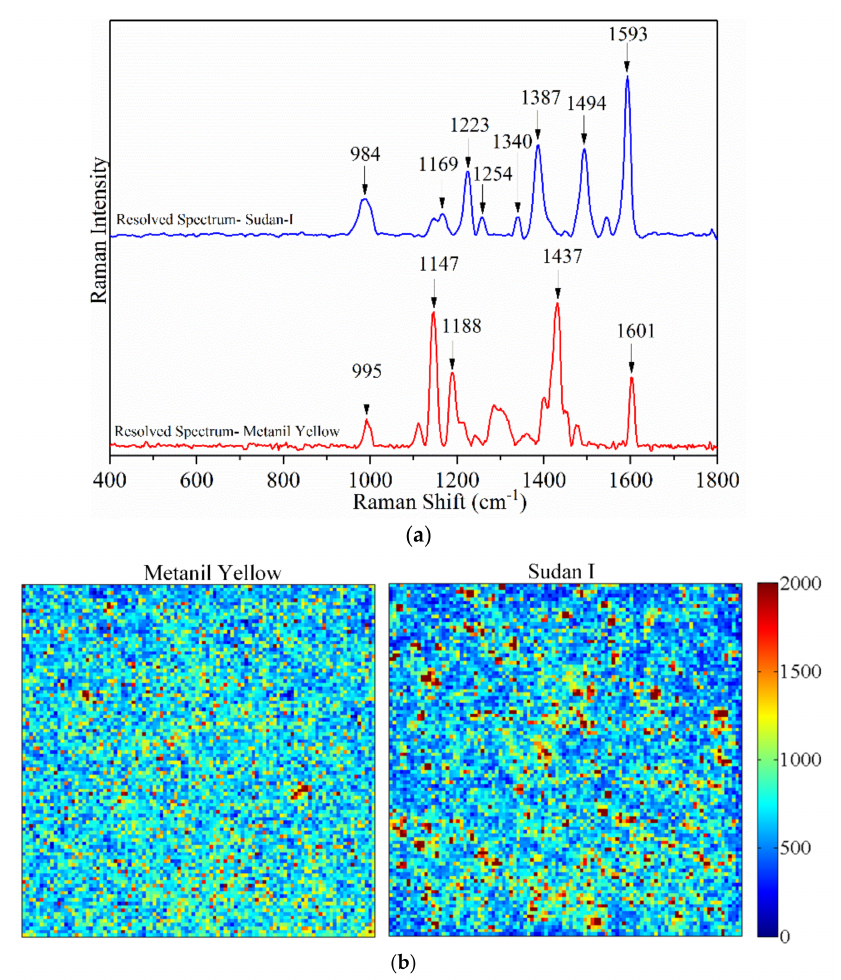
Figure 10. Results of self-modeling mixture analysis of components. ( a ) Resolved spectra of Sudan-I and metanil yellow; ( b ) corresponding contribution